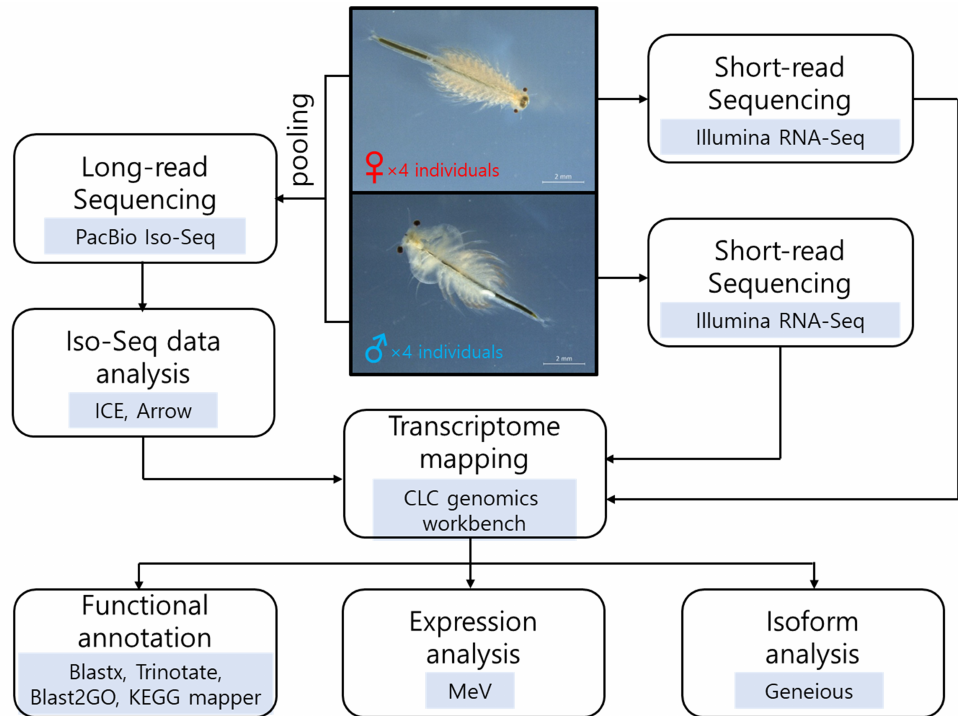
Figure 1. Workflow of the bioinformatic steps. The photographs of female and male Artemia franciscana (scale bar = 2 mm), and the flowchart showing analysis tools used in this